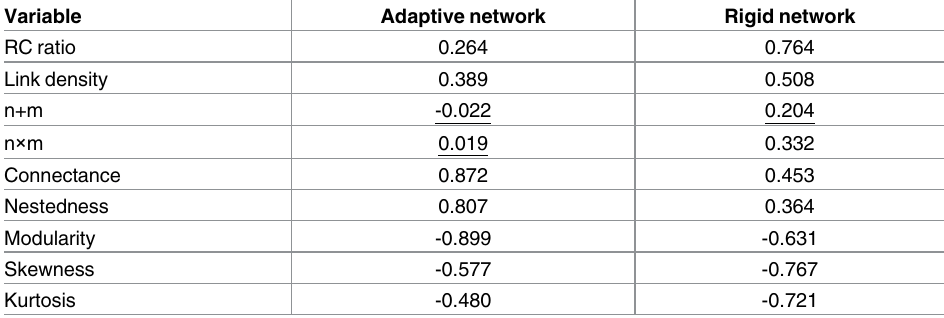
Table 1. Spearman’srank correlations between network structure and robustness (R50, is the per- centage of generalist resources that need to be removedbefore at least 50% of consumer species go extinct).